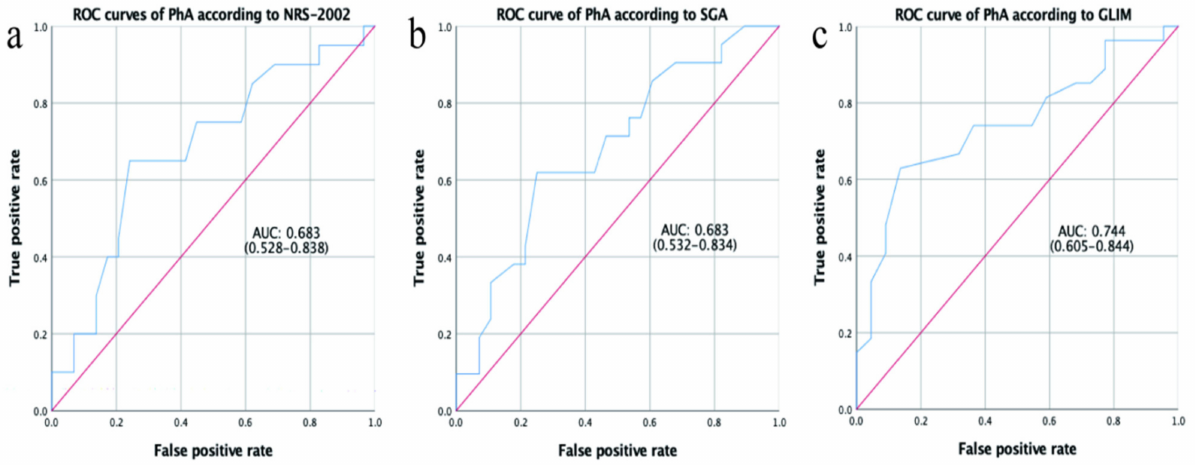
Figure 3. ROC curves of PhA to predict the patient nutrition status according to Nutritional Risk Screening 2002 (NRS-2002, ( a )), Subjective Global Assessment (SGA, ( b )), and Global Leadership Initiative on Malnutrition (GLIM, ( c )). AUC: Area under the